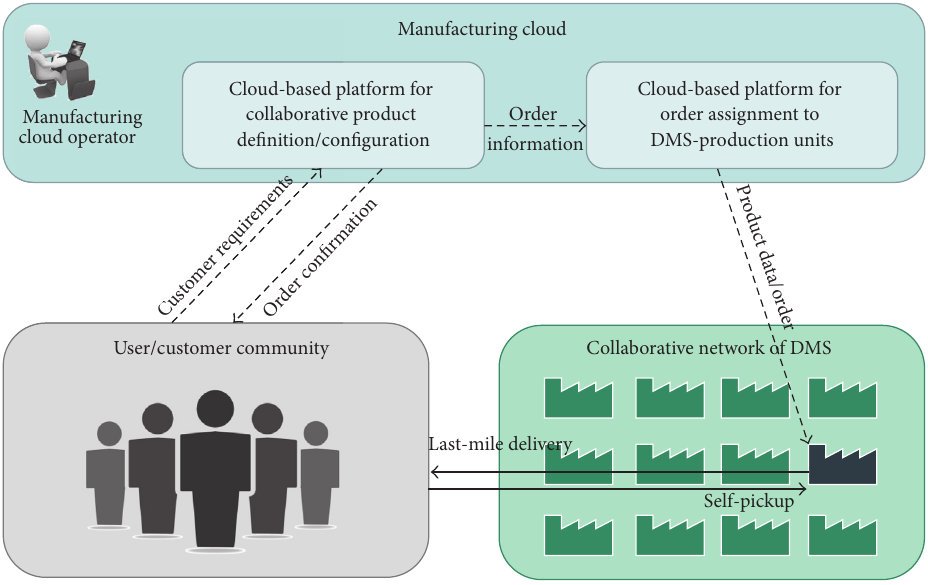
Figure 2: Concept of collaborative cloud manufacturing